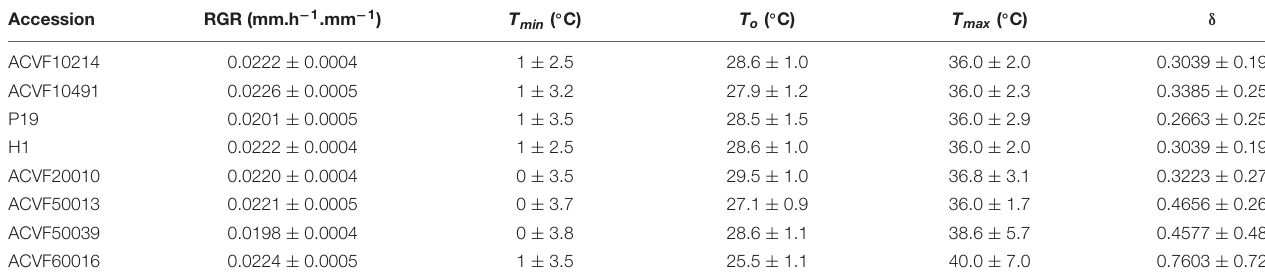
TABLE 4 | Estimated values of the parameters for the beta model fitted to the relative growth rate of the shoot (RGR-sh) data of Lolium perenne accessions in response to constant temperature during heterotrophic